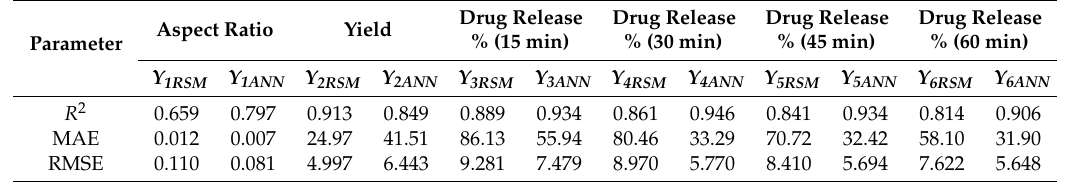
Table 4. Comparison of RSM and ANN.